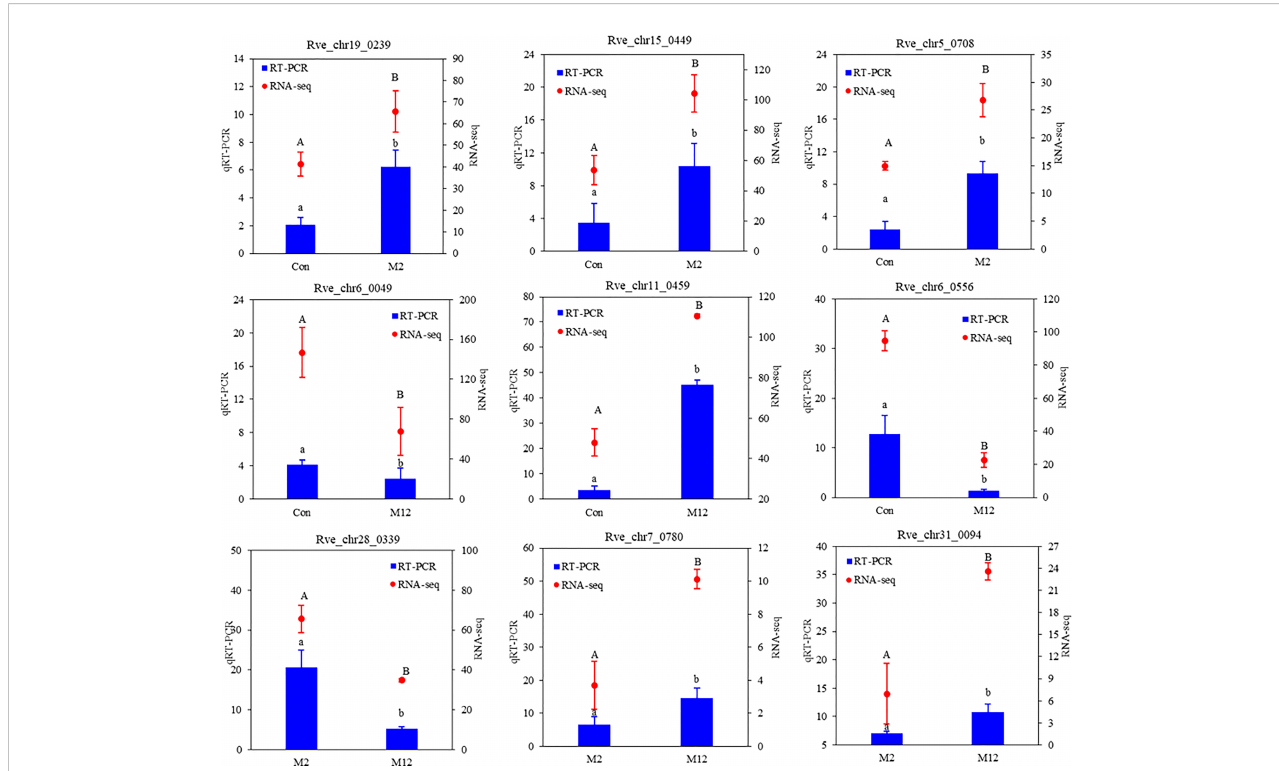
FIGURE 1 Validation of the 9 random DEGs involved in different pairwise comparisons by qRT-PCR. RL28 was selected to normalize the gene expression levels. The data are shown as means ( ± SE) of three replicates. Different superscripted letters indicate signi fi cant differences (P <